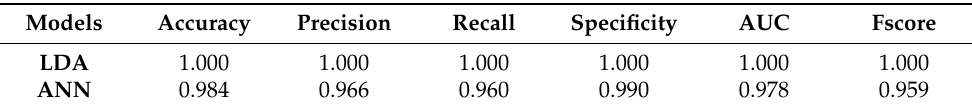
Table 5. Performance parameters of LDA and ANN